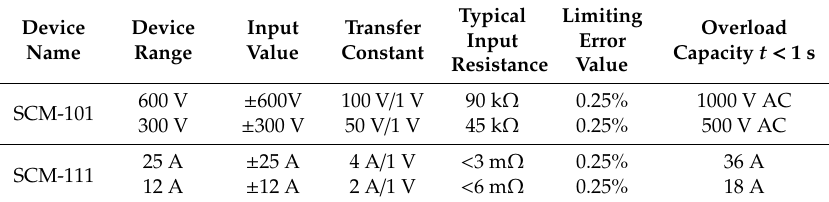
Figure 2. The Off-Grid measurement and the control system data flow. Figure 2. The O ff -Grid measurement and the control system data flow. Table 2. Elcom SCM-101 and SCM-111 products Table 2. Elcom SCM-101 and SCM-111 products parameters.